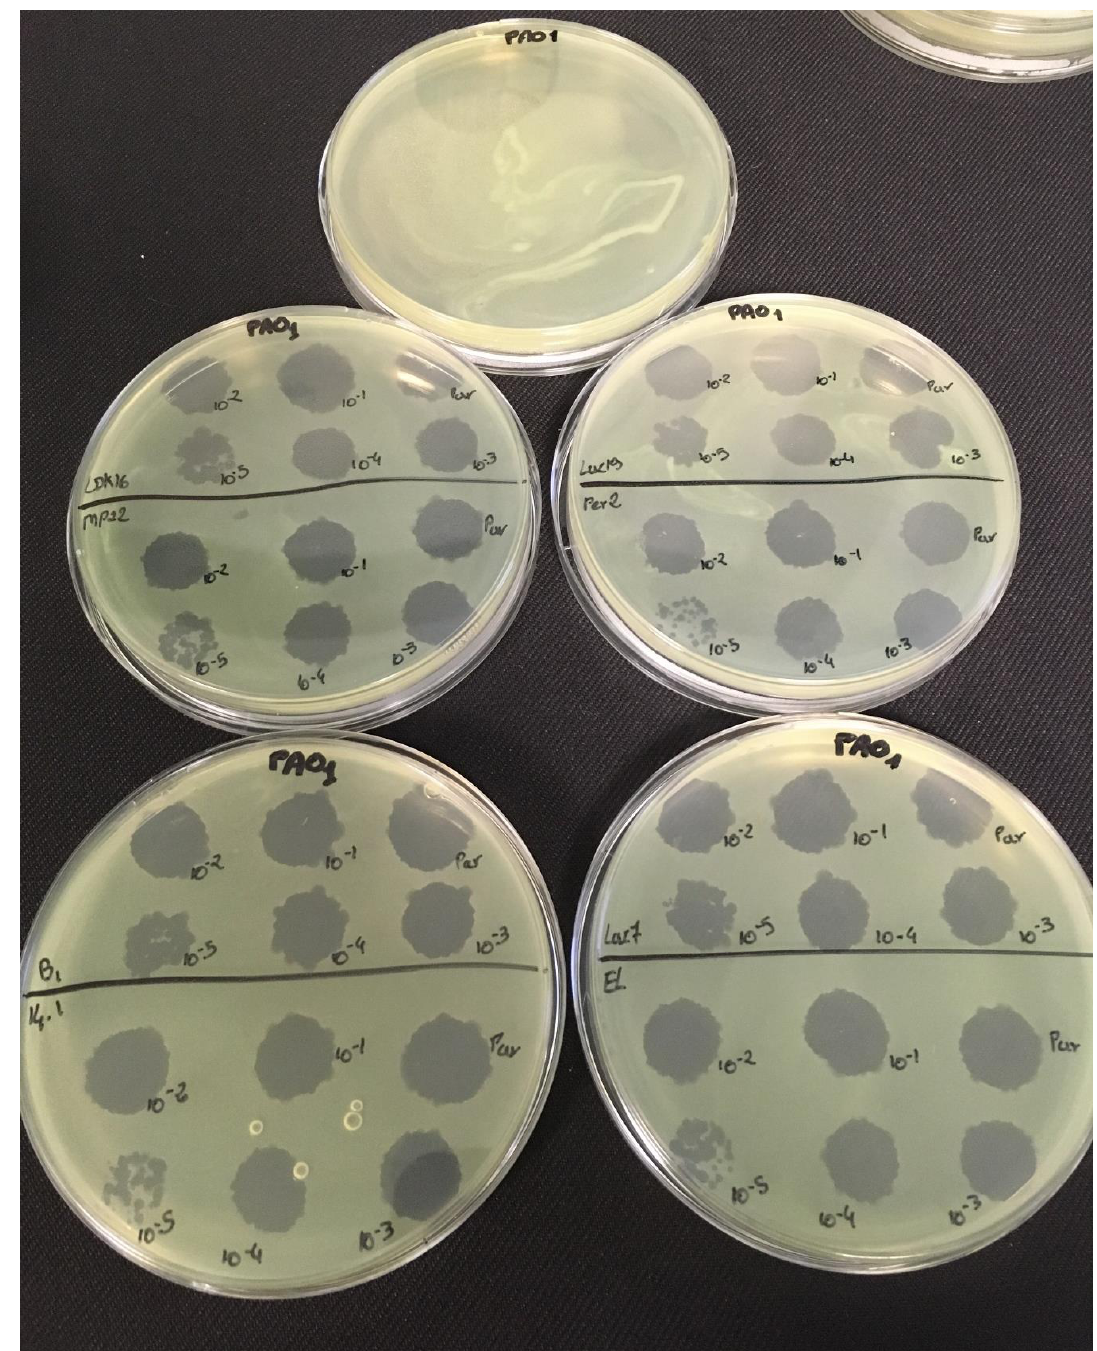
Figure A2. Plaque lysis forming from one spot test assay on the PAO1 reference strain challenged with diluted phage suspensions. Each plate corresponds to plaque lysis from two phages. The first plate at the top of the picture corresponds to the growth control of the strain without phages.